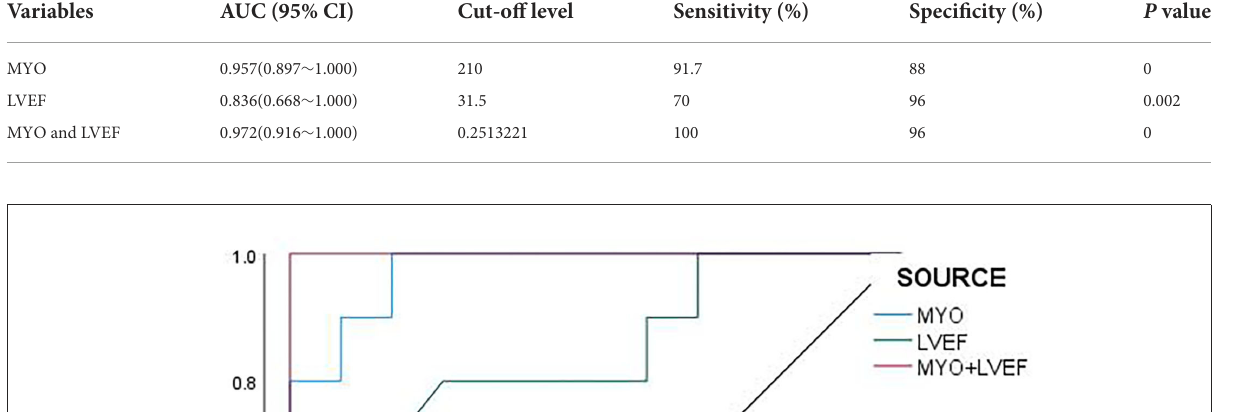
markers of myocardial injury. MYO was positively correlated with CRP and